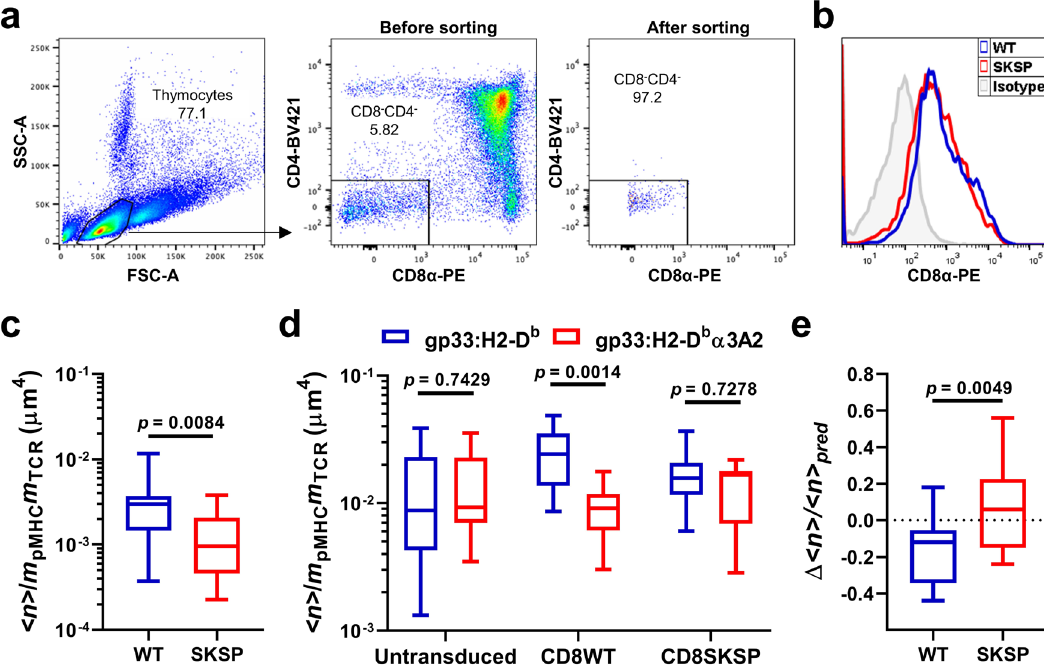
Fig. 5 PD-1 ’ s suppression of TCR-CD8 cooperativity requires CD8 – Lck association. Sorted P14 CD8 − CD4 − (DN) thymocytes were transduced to express CD8 WT or SKSP mutant that abolishes Lck binding, followed by 2D kinetic analysis for negative cooperativity. a Representative CD4 vs CD8 plots of total P14 thymocytes showing the sorting strategy (left and middle) and purity (right) of DN thymocytes. b Representative histogram plot of retroviral- transduced P14 DN thymocytes expressing CD8 WT or SKSP mutant. c Comparison of normalized numbers of bonds formed between RBCs bearing gp33: H2-D b and P14 DN thymocytes transduced to express CD8WT or CD8SKSP ( n = 17 and 15 cells) at 2-s contact time. d Comparison of normalized numbers of bonds formed between untransduced, CD8WT, or CD8SKSP P14 DN thymocytes and RBCs bearing gp33:H2-D b ( n = 11, 11, and 11 cells) or gp33:H2- D b α 3A2 ( n = 10, 10, and 12 cells) at 5-s contact time. e Comparison of normalized bond reductions ( Δ < n >/ <n > pred ) between CD8WT and groups CD8SKSP ( n = 16 and 17 cells). Data are presented by box-whisker plots (the center line labels median, the box contains the two middle quantiles, and the whiskers mark the min and the max) with the n values indicating the numbers of cells measured per condition. p values were calculated using Mann – Whitney